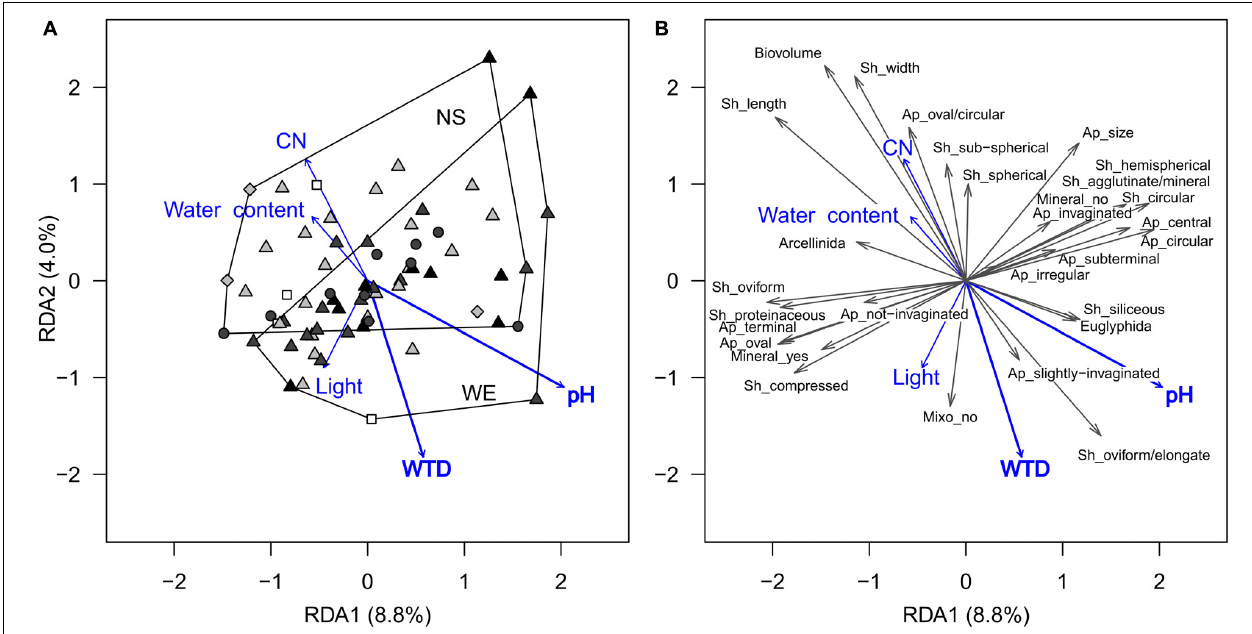
FIGURE 3 | Ordination diagrams based on the result of RDA showing the variation in testate amoeba functional traits composition (scaled data, only traits observed in more than 15 samples are shown) in surface samples from the Sungai Buluh peatland. (A) Sample scores: the polygons encircle samples from the same transect (NS or WE); symbol colour denotes the microrelief (black – hummock, dark grey – flat, light grey – hollow, white – pool), symbol shape denotes the substrate type (circle – herbal litter, square – pool sediments, diamond – rooted soil, triangles – tree litter). (B) Functional trait scores (multiplied by 2 to improve readability). The number in parentheses is the proportion of the total variance explained by the axis. Significant environmental variables (WTD and pH) are shown in bold. Trait abbreviations: Sh – shell, Ap – aperture, Mineral – mineral presence, Mixo – mixotrophy. WTD, for water table depth; CN, for C-to-N ratio; Light, for light intensity.